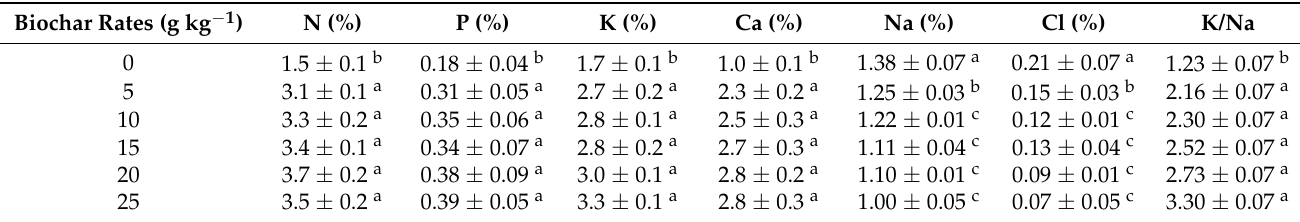
Table 4. Effect of SWB on the nutrient concentrations in plant shoots.